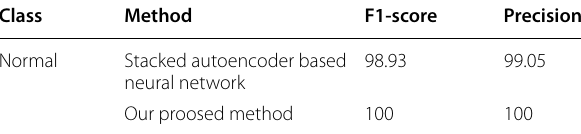
Table 5 Performance comparison of the proposed model with the method presented in [27] in terms of Precision and